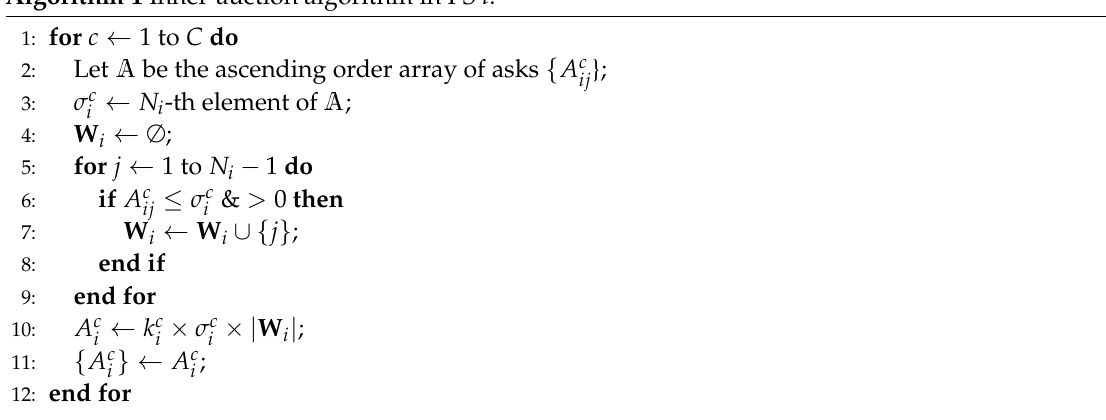
Algorithm 1 Inner-auction algorithm in PS i .